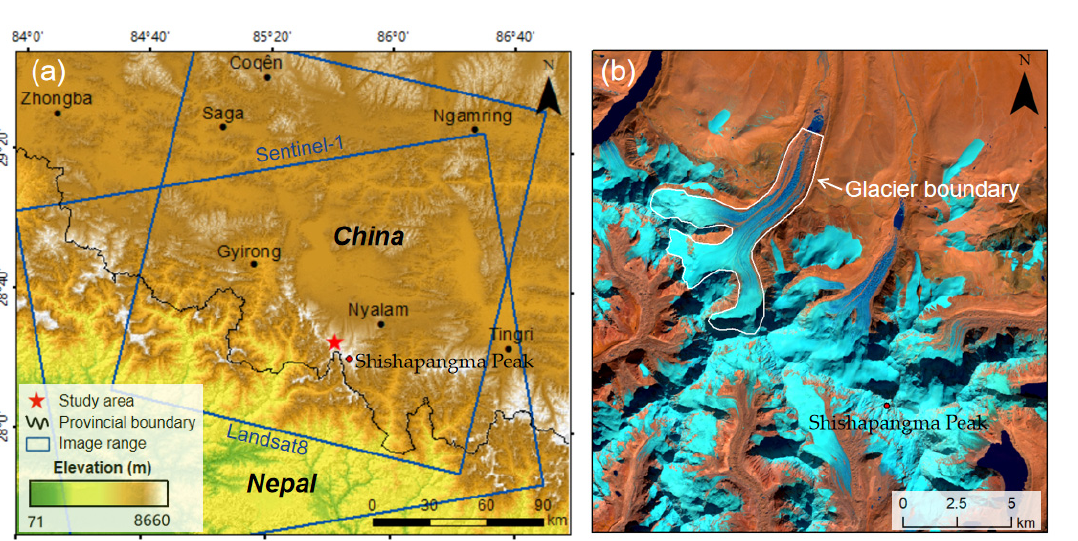
Figure 1. ( a ) Data coverage map of the experimental area and ( b ) false color image of the glacier with Landsat 8 OLI Data (652-band Fake Color Synthesis). In ( a ), the study area is located near Shishapangma Peak in Nyalam County, Tibet Autonomous Region, China, and about 16 km from the China-Nepal border. In ( b ), blueish colors represent glacier and snow-covered areas, and reddish colors represent bare surface and surface moraine glacier areas.